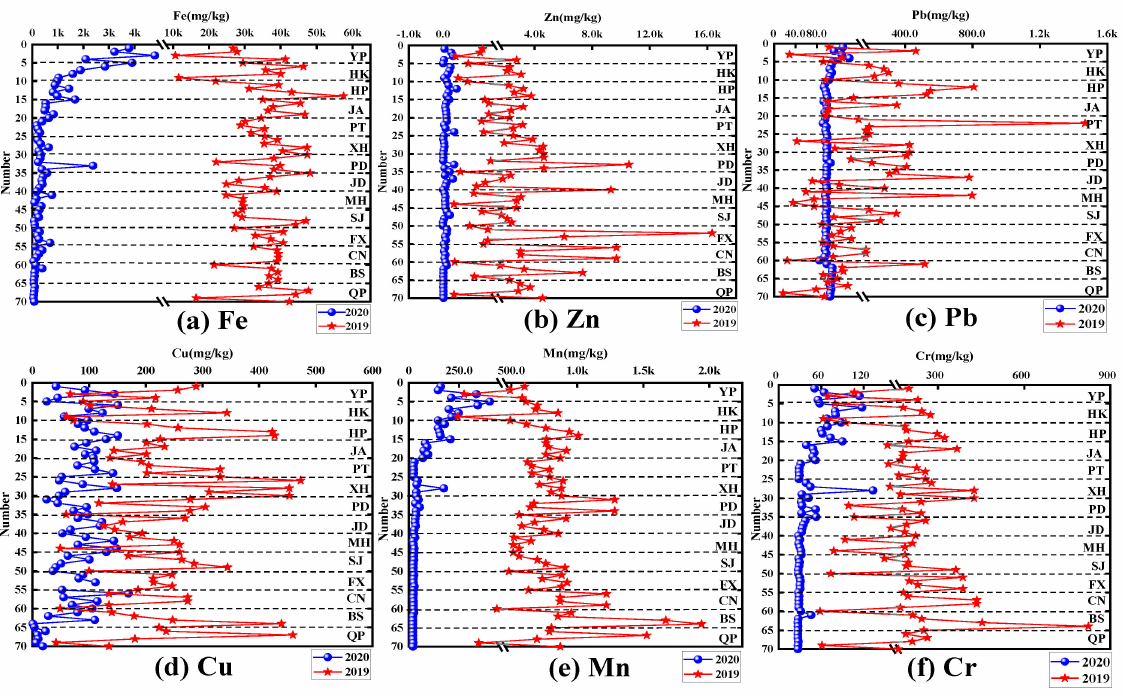
Figure 4. Spatial variation characteristics of the heavy metal content before and after COVID-19